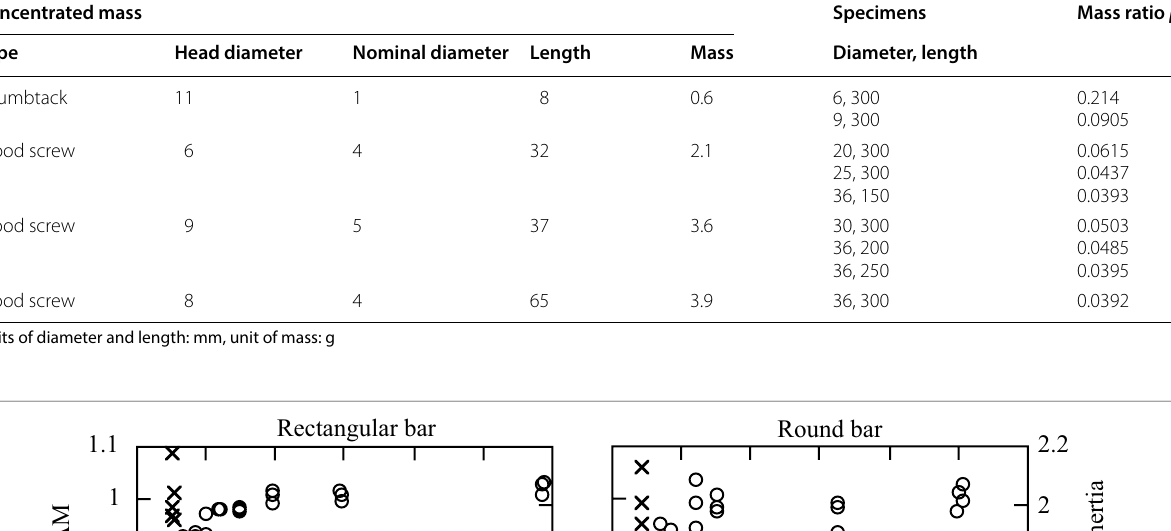
Table 2 Concentrated masses (thumbtacks, wood screws) attached to small round bars Concentrated mass